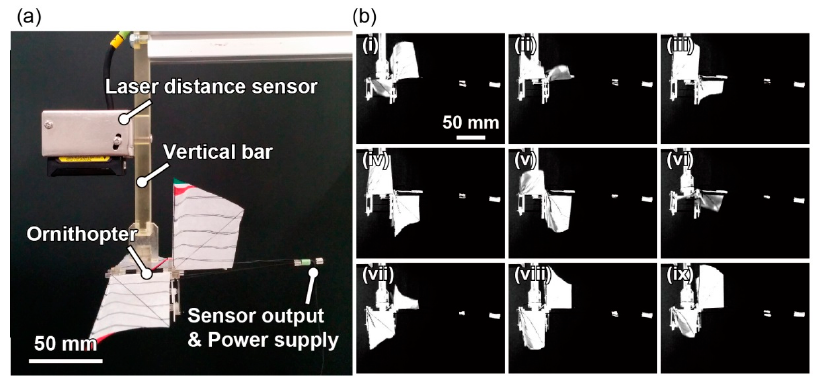
Figure 3. ( a ) Experimental setup in tethered motion; and ( b ) high-speed camera images of the ornithopter with the gear position set at 270° with positive rotation and a measured phase angle of 225°. The time interval is 10 ms.